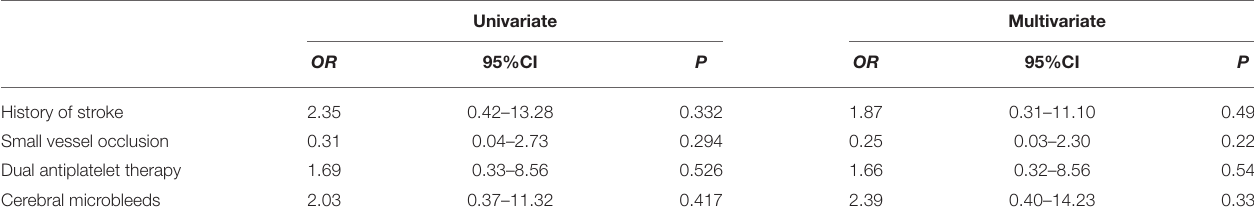
TABLE 4 | Univariate and multivariate logistic regression analyses for hemorrhagic complications. Univariate Multivariate OR 95%CI P OR 95%CI P History of stroke 2.35 Small vessel occlusion Cerebral microbleeds